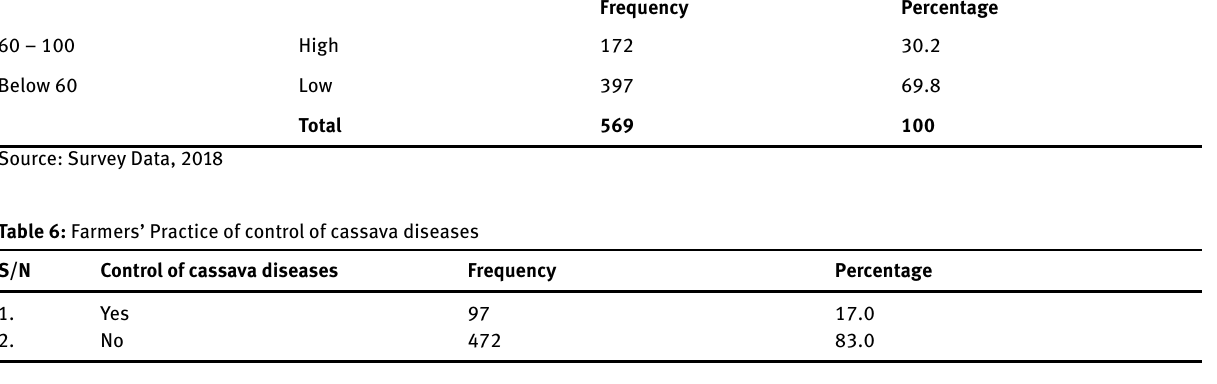
Table 5: Grand Knowledge level of Cassava farmers with respect to Disease Control Category of score (%)